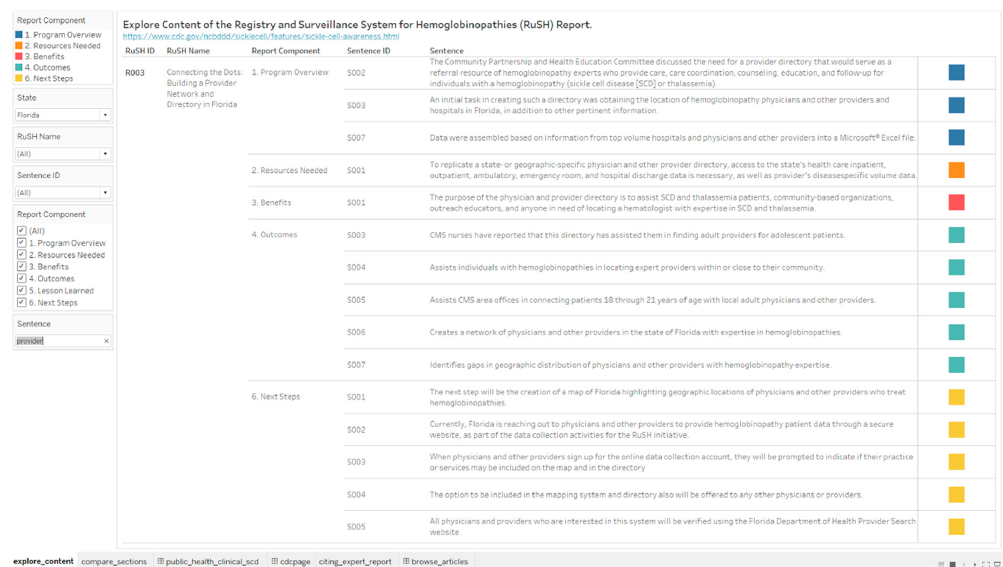
Figure 5. An interactive analytics enclosure table design for exploring textual data in the Registry and Surveillance System for Hemoglobinopathies (RuSH)